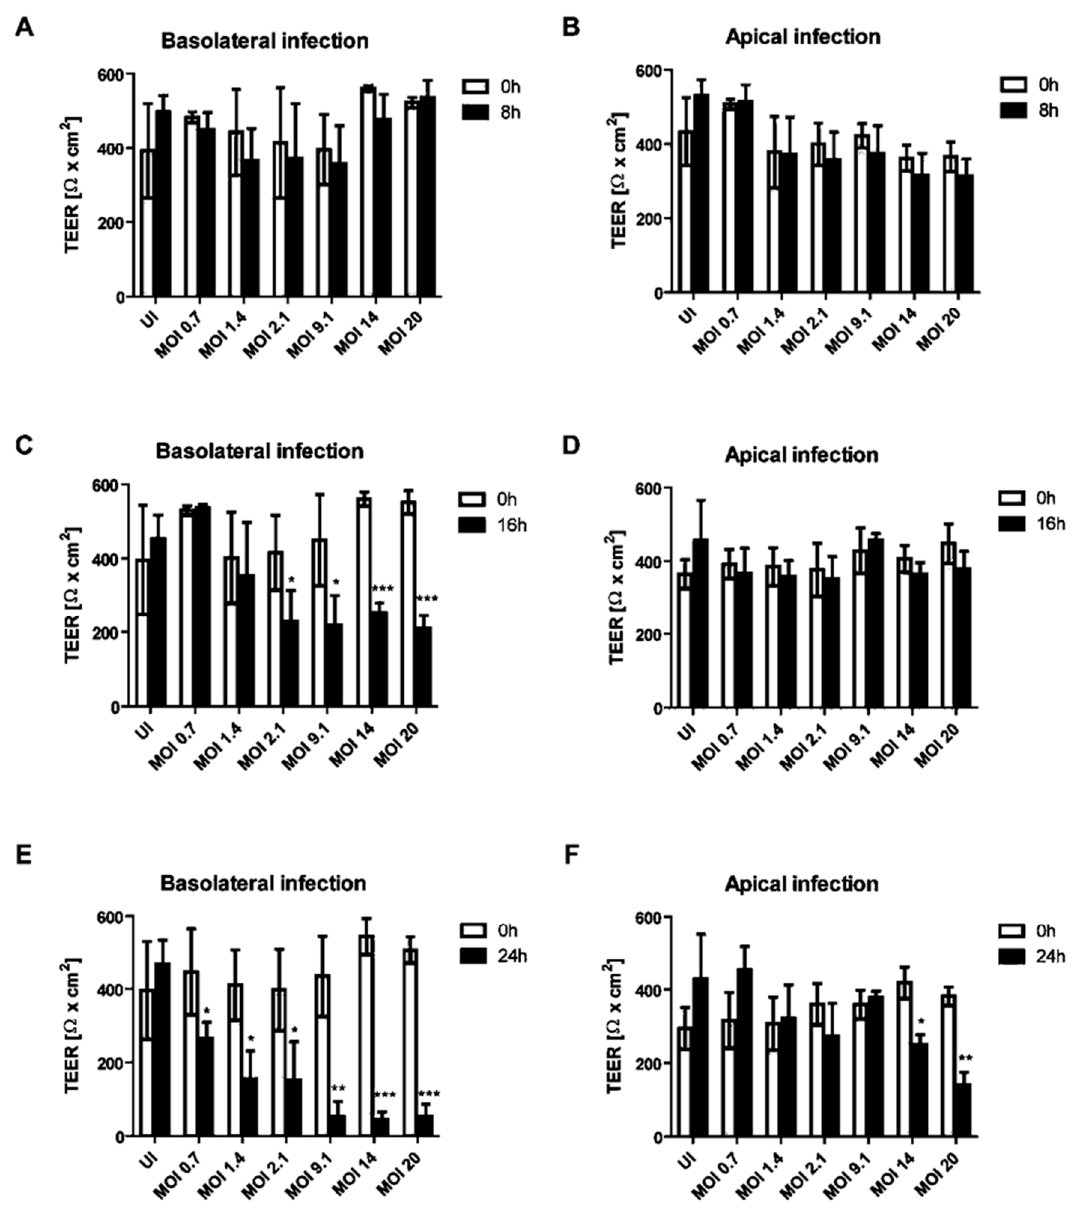
Figure 2. Decrease of transepithelial electrical resistance (TEER) of HIBCPP cells is dependent on the side of infection with E-30. Barrier integrity of HIBCPP cells layer was evaluated following basolateral (T = 8 h ( A ), T = 16 h ( C ), T = 24 h ( E )) and apical (T = 8 h ( B ), T = 16 h ( D ), T = 24 h ( F )) infection with E-30 via measurements of the transepithelial electrical resistance (TEER), for all investigated conditions (uninfected (UI) and infected with MOI 0.7, MOI 1.4, MOI 2.1, MOI 9.1, MOI 14 and MOI 20). Data are shown as mean ± SD of 3 independent experiments, each performed in triplicates. Statistical comparisons with p -values are shown for T = 8 h, T = 16 h and T = 24 h compared to the respective TEER at T = 0 h for each MOI or the uninfected control ( = UI). For statistical analysis, the Student’s t -test was used. p -values are displayed as follows: * p < 0.05; ** p < 0.001 and *** p < 0.0001. The statistical analysis was performed with the software GraphPad QuickCalcs.